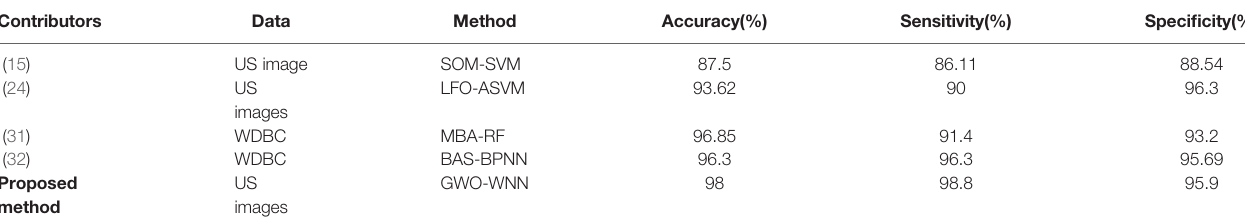
TABLE 2 | Classi fi cation performance of the proposed GWO-tuned WNN with existing classi fi ers.